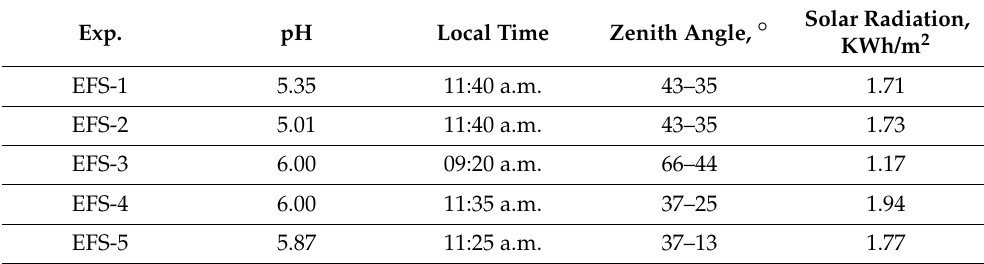
Table 3. Operating conditions of photocatalytic experiments using black sand as photocatalyst and solar radiation as light source.